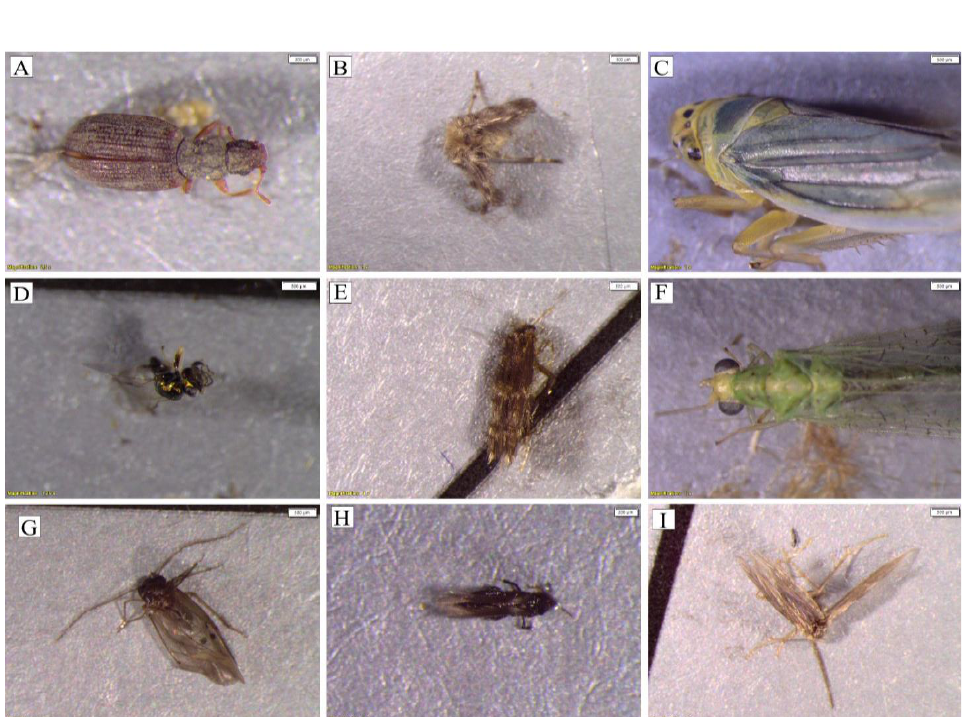
Figure 4. Photographs of some of the insects captured. ( A ) Coleoptera (Latridiidae), ( B ) Diptera ( Psychodidae ), ( C ) Hemiptera ( Cicadella viridis ), ( D ) Hymenoptera (Chrysididae), ( E ) Lepidoptera, ( F ) Neuroptera ( Chrysoperla carnea ), ( G ) Psocoptera (Psocomorpha), ( H ) Thysanoptera, and ( I ) Trichop- tera (Hydroptilidae). Table 2. Number of specimens and morphospecies of the orders trapped throughout the experi- ment.